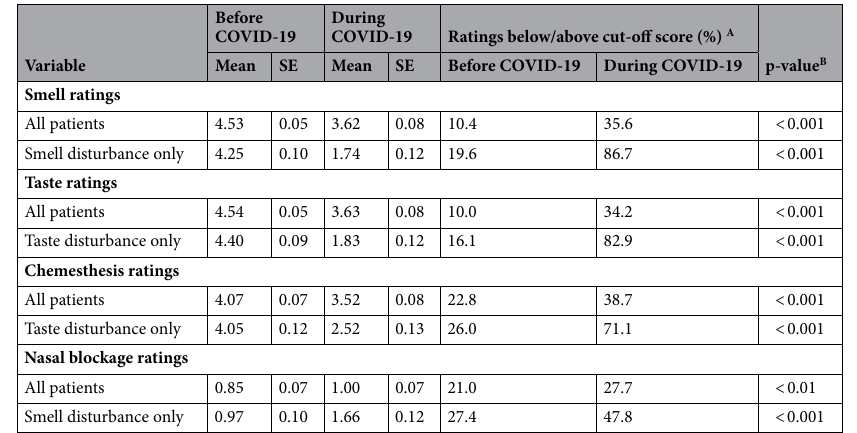
Table 4. Self-ratings of smell, taste, chemesthesis, and nasal obstruction before and during COVID-19. A For smell, taste and chemesthesis, ratings are below the cut-off score of 4. For nasal blockage, ratings are above the cut-off score of 1. B Wilcoxon matched pairs signed-rank test.